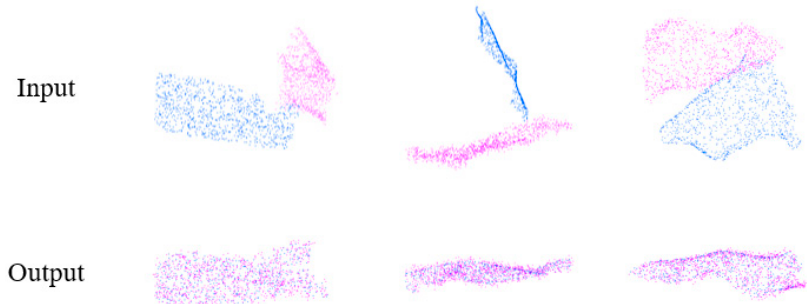
Figure 12. Examples of registering several noisy point clouds with our method.